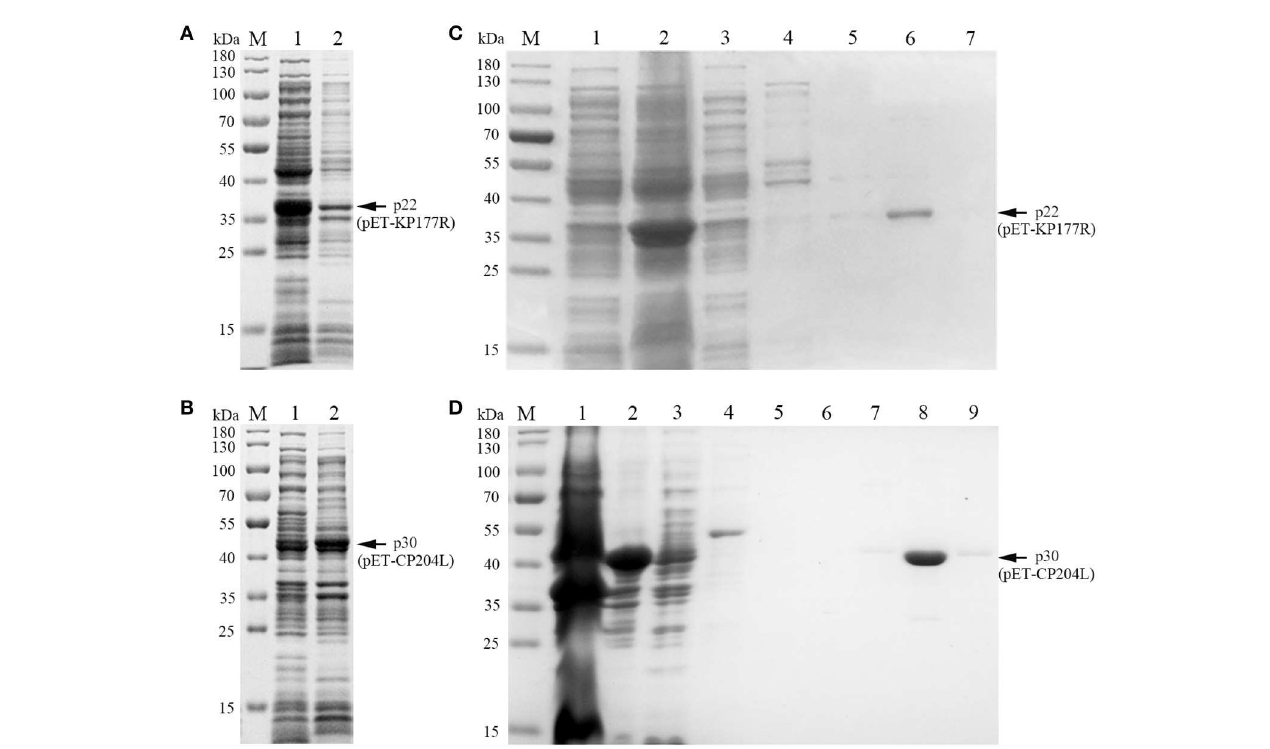
FIGURE2 Soluble analysis and purification of p22 and p30 proteins. (A, B) Soluble analysis of p22 protein (A) and p30 protein (B) . M, Marker; (1) Supernatant after ultrasound; (2) Precipitation after ultrasound. (C, D) The purification results of p22 protein (C) and p30 protein (D) . (C) M, Marker; (1–7) Flow through fluid, supernatant after ultrasound, 20, 40, 50, 100, and 200mM imidazole. (D) M, Marker; (1–9) Precipitation after ultrasound, supernatant after ultrasound, flow through fluid, 20, 40, 50, 100, 200, and 200mM imidazole.